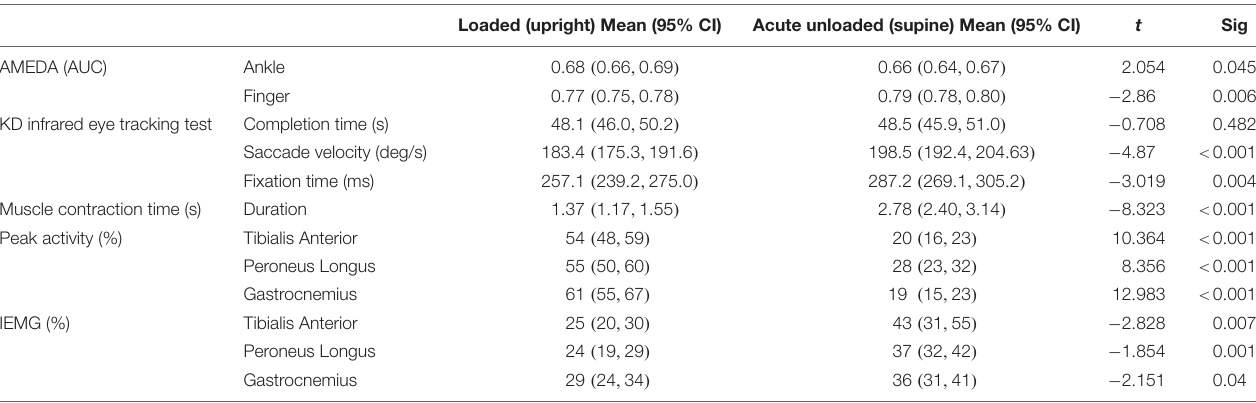
TABLE 2 | Paired sample t -test loaded verses acute unloaded.